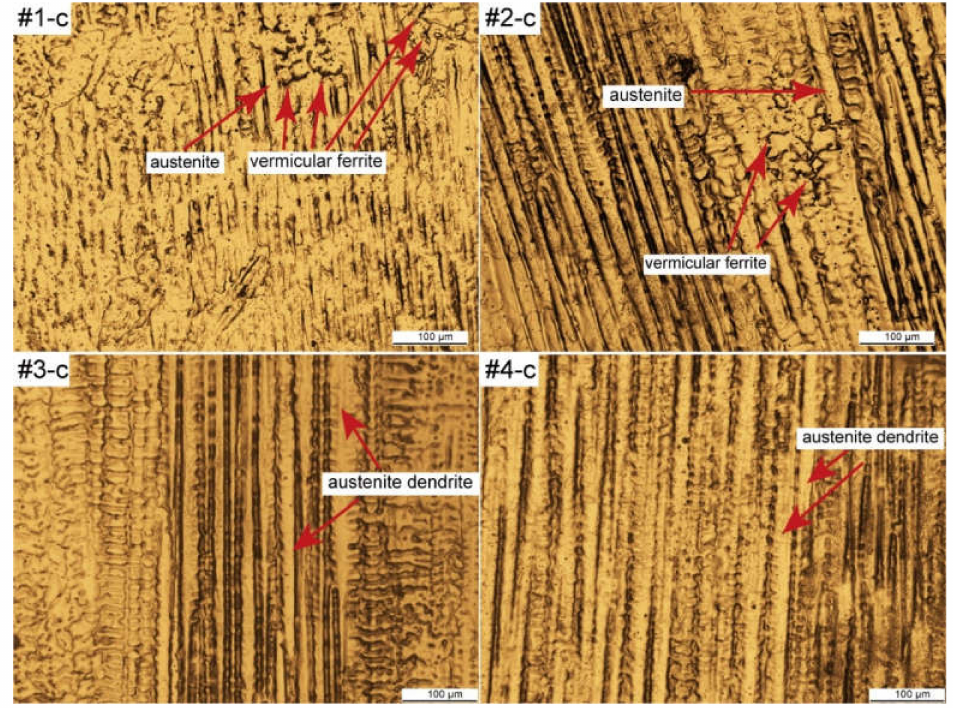
Figure 5. Microstructure of the middle region of as-deposited samples: (#1-c) sample #1, (#2-c) sample #2, (#3-c) sample #3 and (#4-c) sample